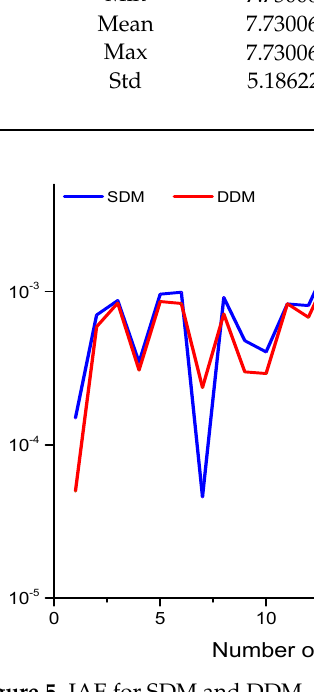
Figure 5. IAE for SDM and DDM, solar cell.